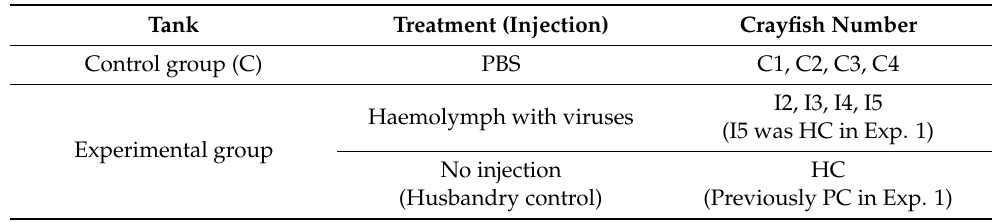
Table 3. Design for Experiment